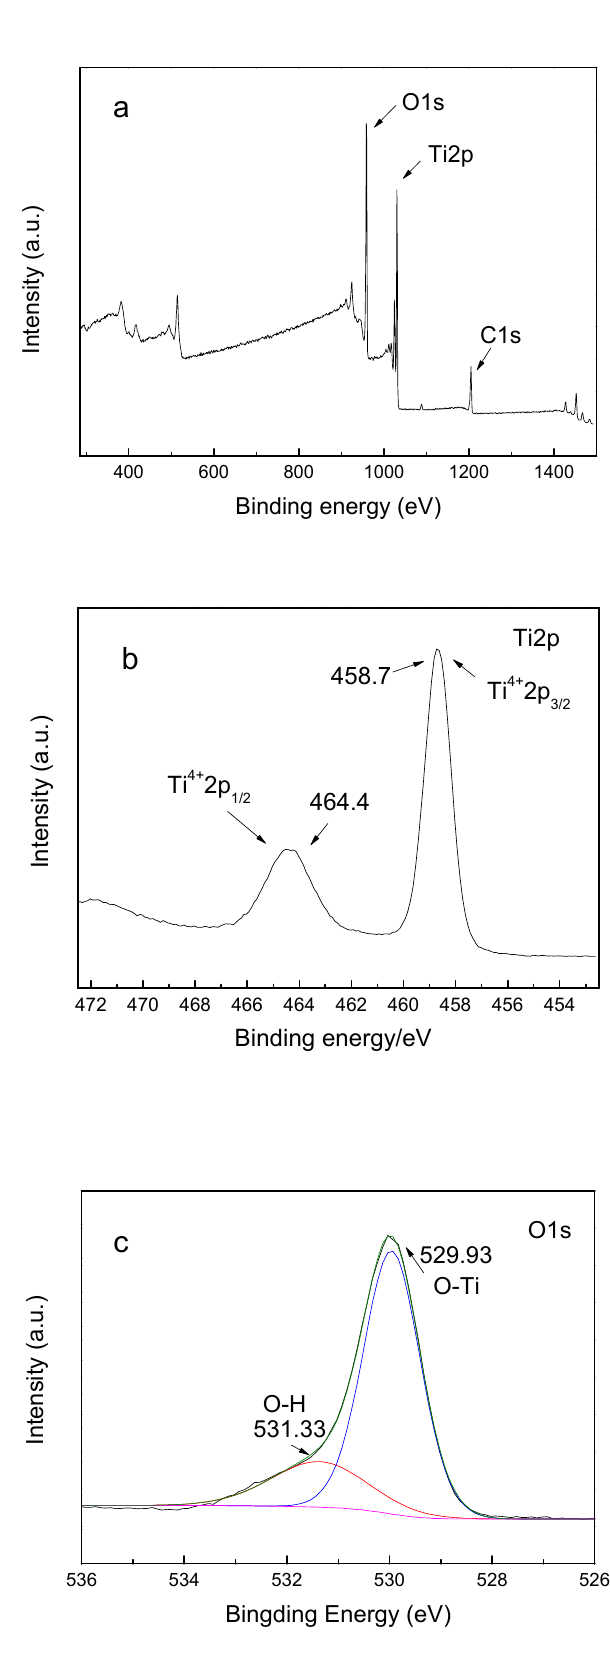
Figure 4. ( a ) Survey XPS spectrum of HTNTs and high-resolution spectrum for ( b ) Ti 2p and ( c ) O 1s.